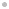
Standardized (Cohen’s d) differences of positional variables between the control and experimental groups (grey ⦁ dots represent U15 age groups, while the ▲ black triangles represent the U17 age groups).Error bars indicate uncertainty in the true mean changes with 90% confidence intervals. Light grey zone reflects trivial values. Values towards the right means higher values for the experimental group, while higher values towards the left means higher values for the control group. SEI: spatial exploration index; ApEn: approximate entropy.